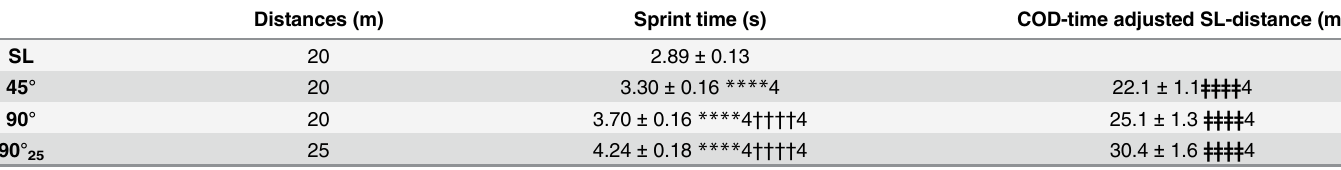
Table 2. Non-adjusted and change of direction-time-adjusted straight-line distances.